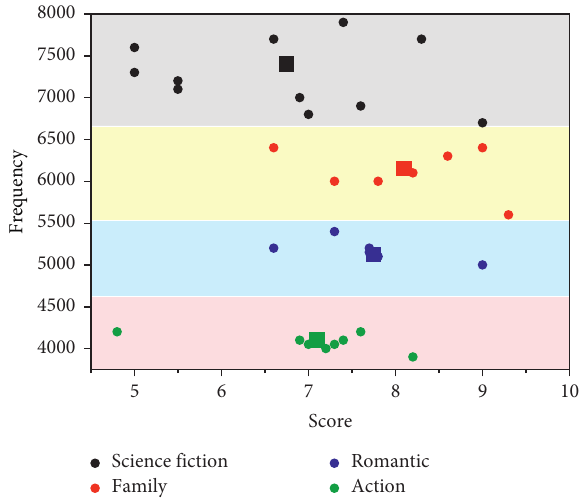
Figure 5: Clustering analysis results of film data.